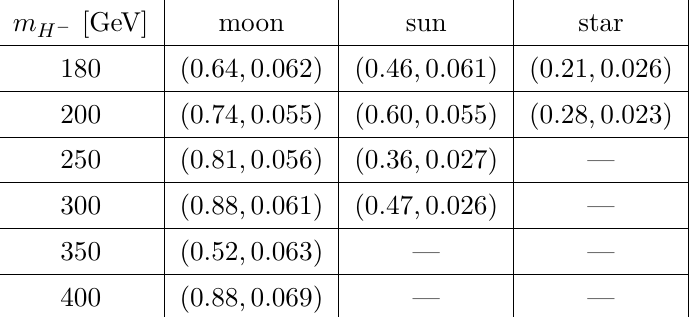
Table 3 . Numerical values of the Yukawa couplings ( y Q , y τ ) for the benchmark points shown in figures 4 and